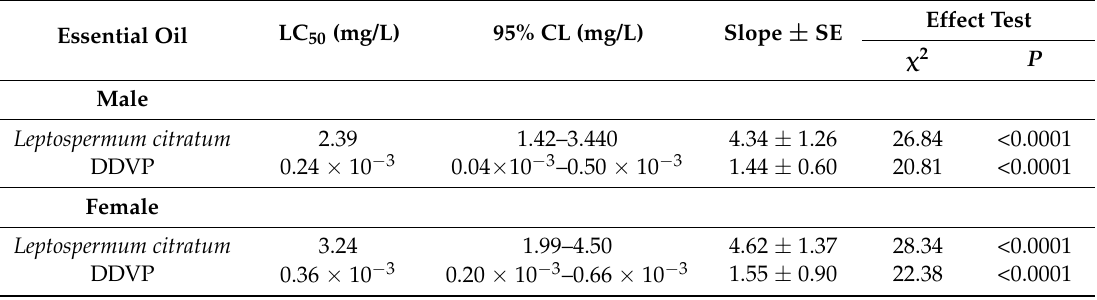
Table 2. LC 50 values of fumigant essential oils active against